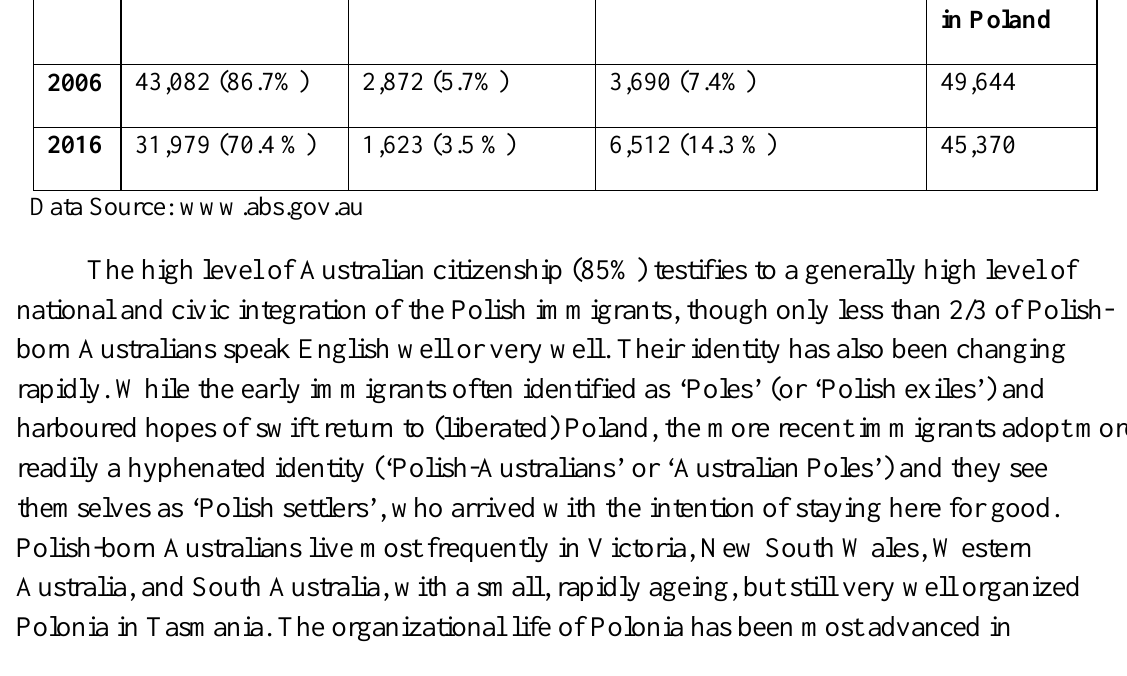
Table 2. Major religious affiliations amongst Poland-born Australians Catholic